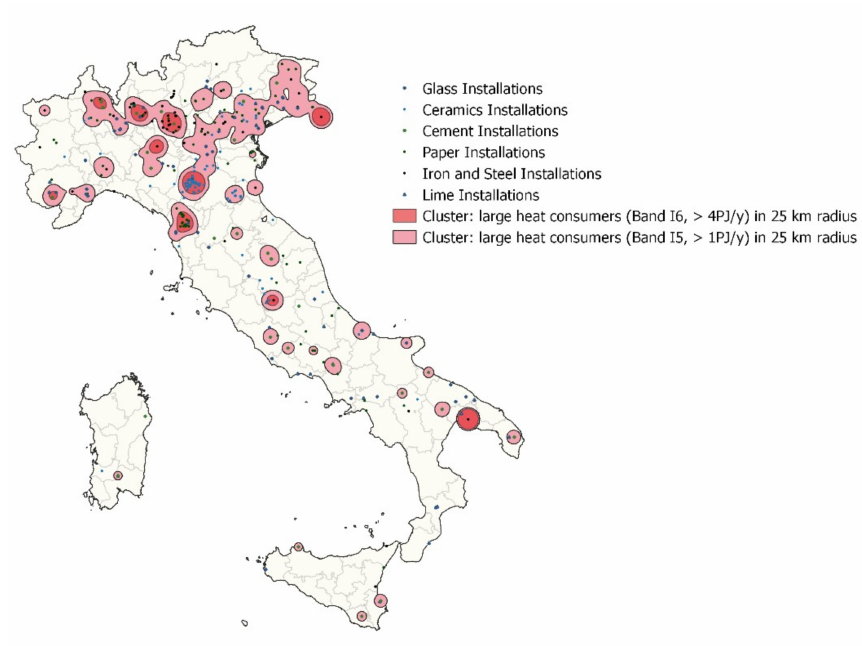
Figure 6. Clusters of industrial installations based on thermal energy